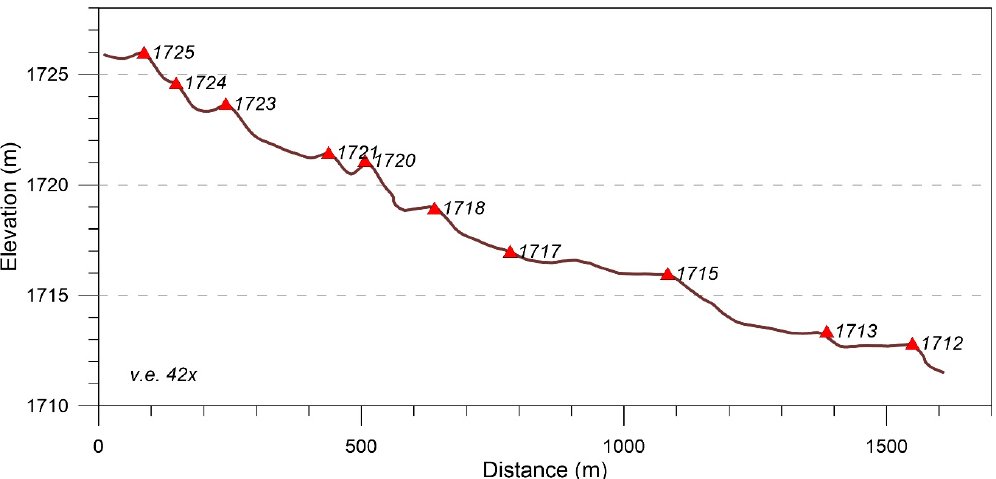
Figure 5. Topographic profile across the beach ridges at the Tobar transect measured by a laser total station referenced to a second class 0 vertical order survey point. Berm crests are noted by red triangles and are labeled with their estimated still-water elevation, as explained in Figure 4.